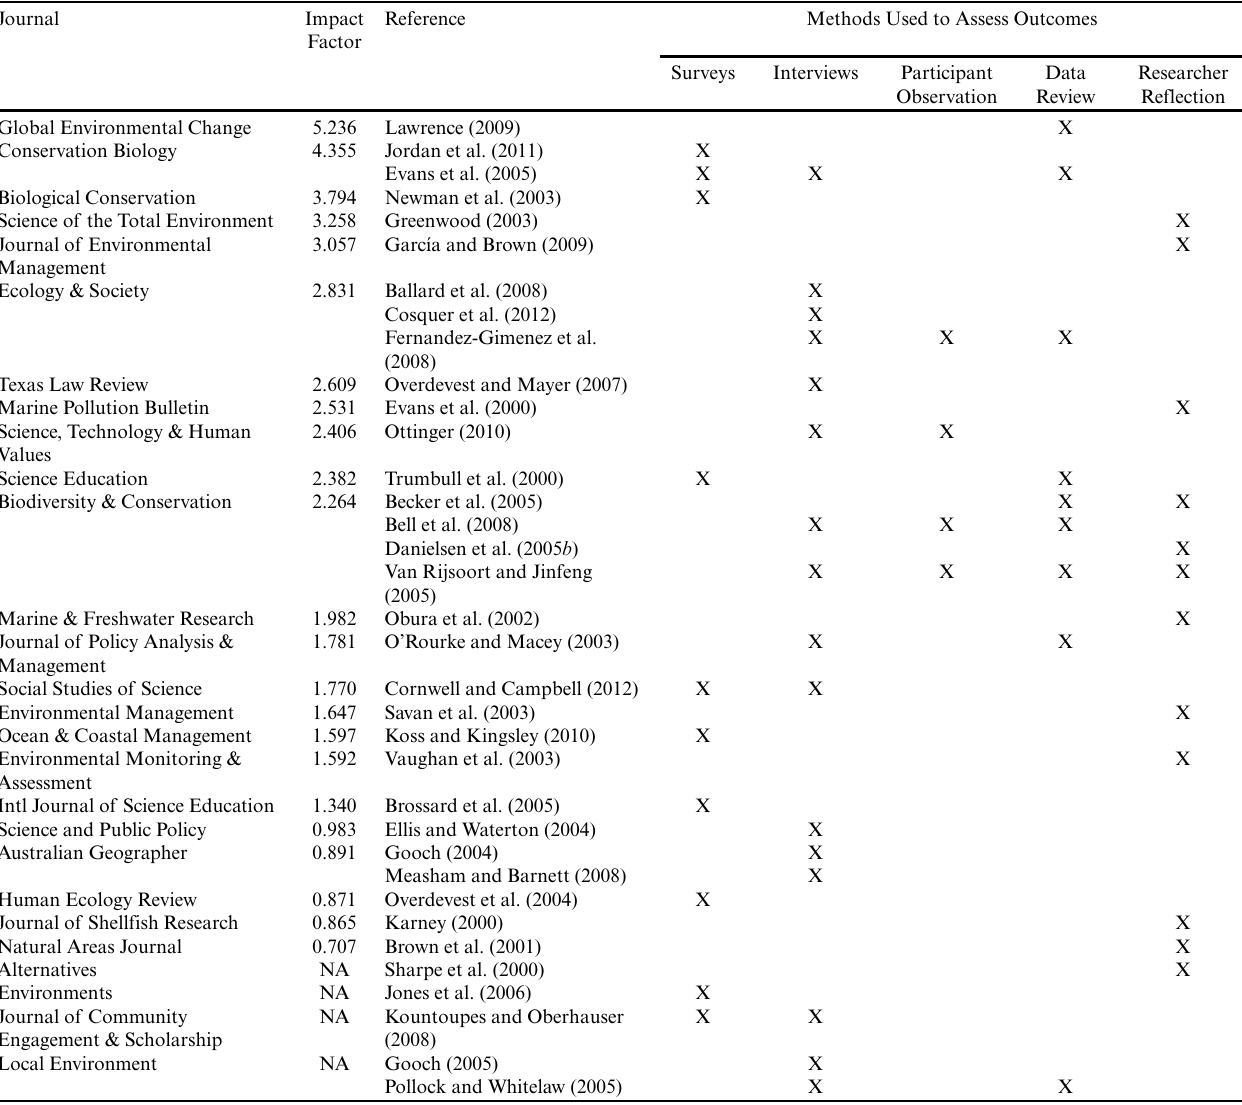
Table 3 . Journal impact factors and research study design styles of articles reporting outcomes for individuals and communities resulting from volunteer environmental